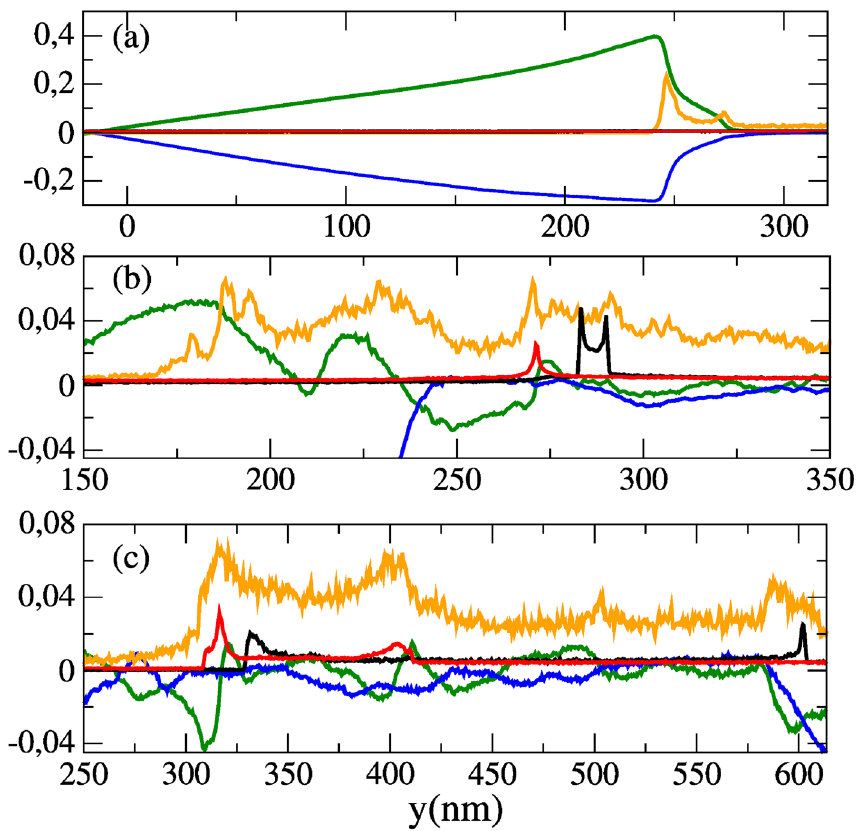
Figure 6. Lineouts of the electron ( n e ( n c ) , orange) and proton ( n p ( n c ) , black) and Boron ( n b ( n c ) , red) number densities, and of the longitudinal electric field ( E y ( 1 200 nm, at ( a ) t= 50 T L , ( b ) t= 90 T L and ( c ) t along x =